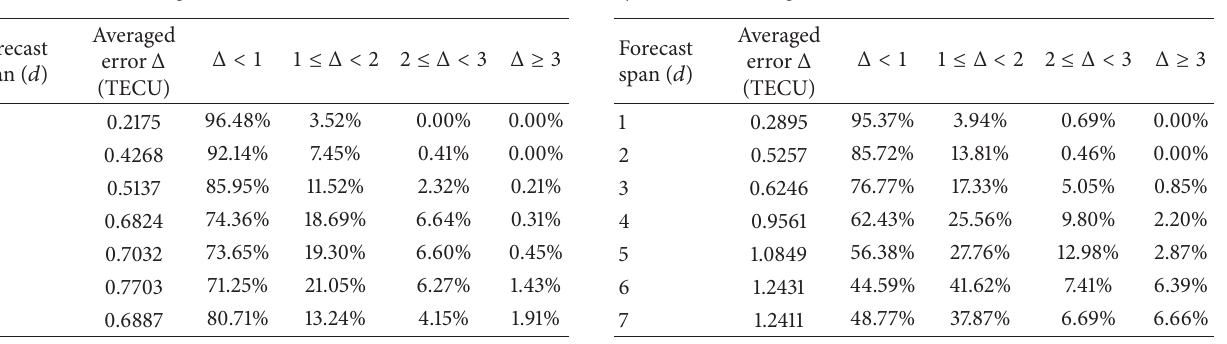
Table 2: Statistics of forecasting precisions of different time scales by nonlinear forecasting.